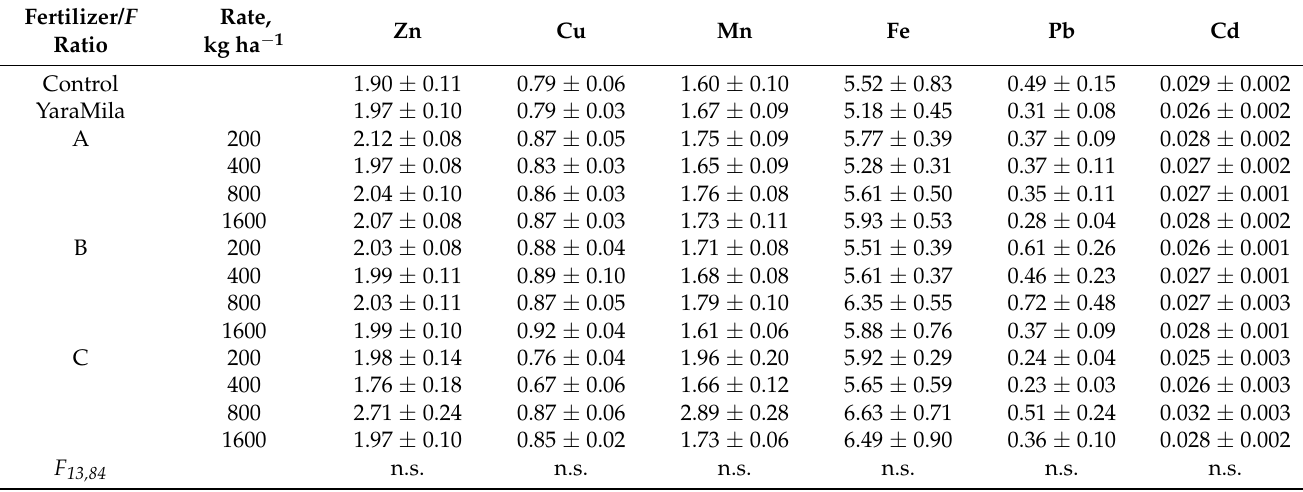
Table 9. Effect of bio-fertilizer application on micronutrients, lead and cadmium content of tomato fruits in mg kg − 1 DM (mean ± standard error). Fertilizer/ F